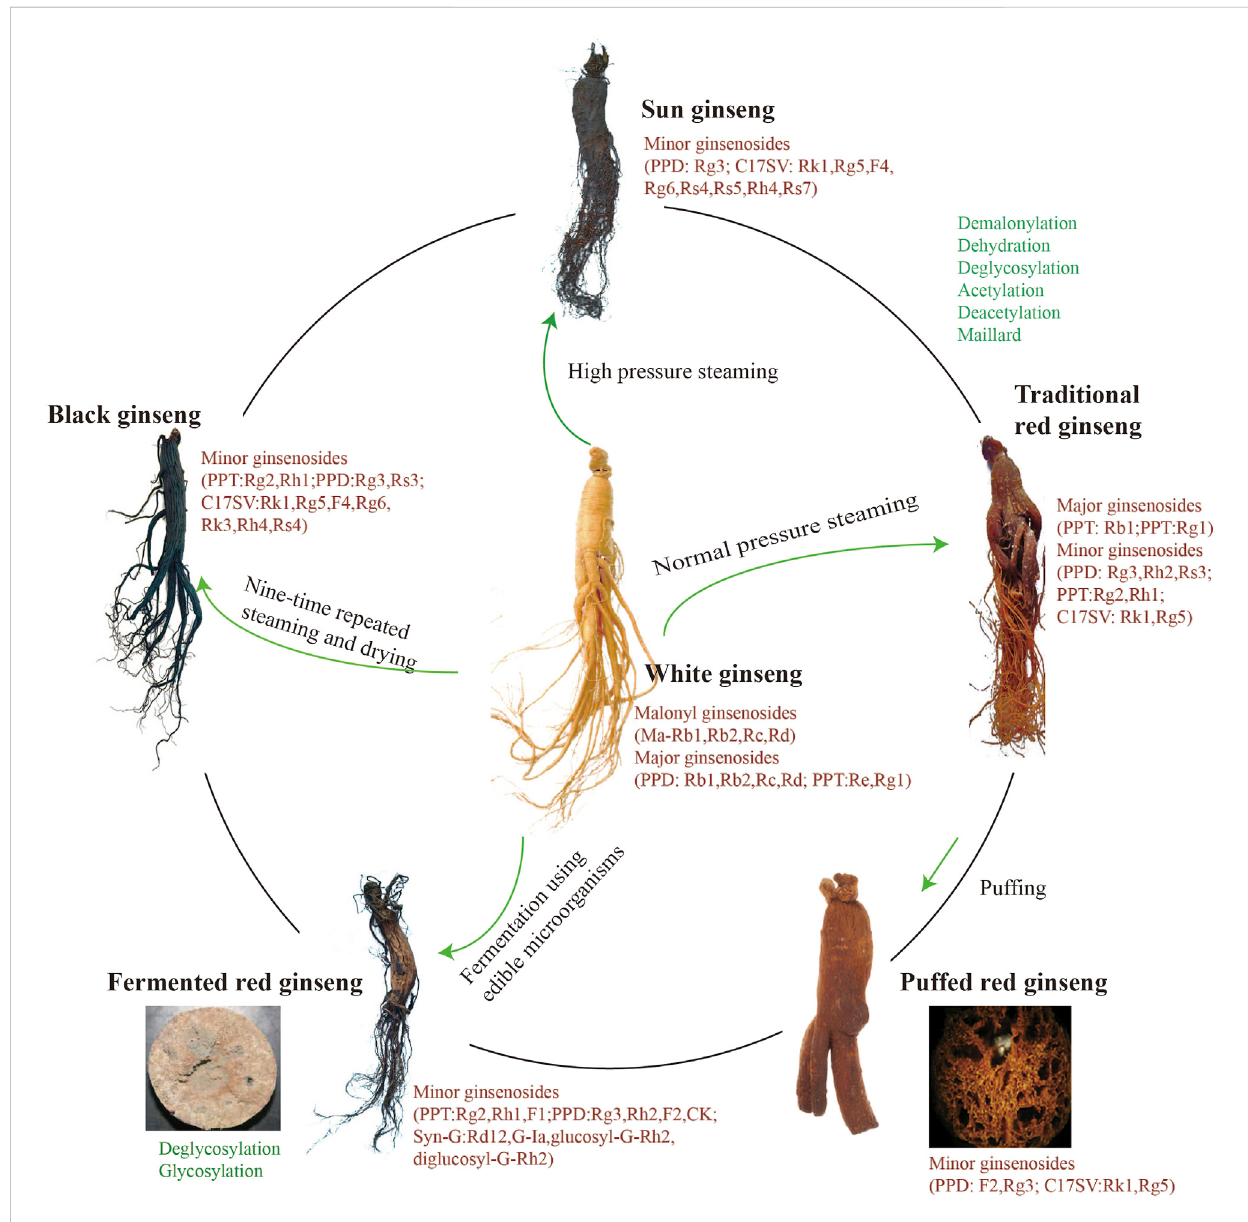
FIGURE 1 Various types of red